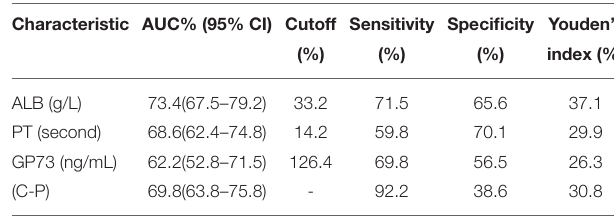
TABLE 3 | Diagnostic accuracy of single variables in predicting esophageal variceal